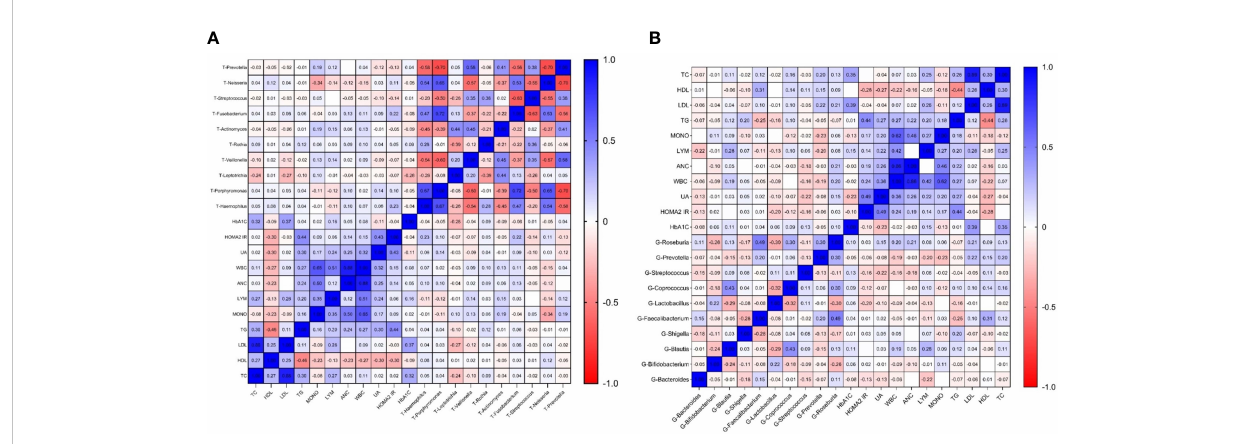
FIGURE 6 Correlation heatmap of microbiota abundance and serum indexes in T2DM (Figure (A) is the correlation heatmap between oral fl ora and serum indexes; Figure (B) is the correlation heatmap between intestinal fl ora and serum